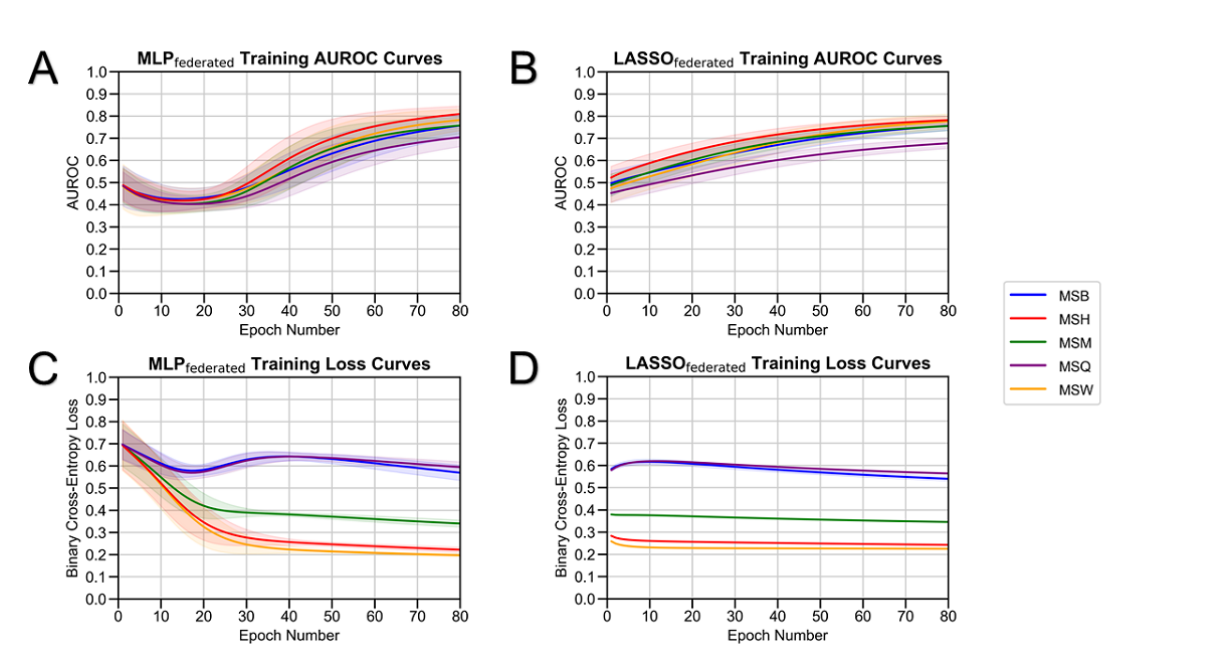
Figure 2. Federated model training. The performance of (A) federated MLP and (B) federated LASSO models, as measured by AUROCs versus the number of training epochs. The binary cross-entropy loss of (C) federated MLP and (D) federated LASSO models versus the number of training epochs. AUROC: area under the receiver operating characteristic curve; LASSO: least absolute shrinkage and selection operator; MLP: multilayer perceptron; MSB: Mount Sinai Brooklyn; MSH: Mount Sinai Hospital; MSM: Mount Sinai Morningside; MSQ: Mount Sinai Queens; MSW: Mount Sinai